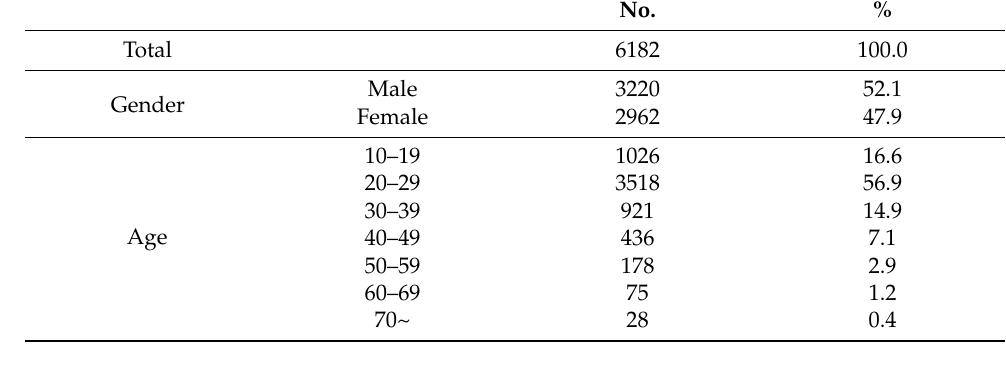
Table 1. Distributions of gender and age.